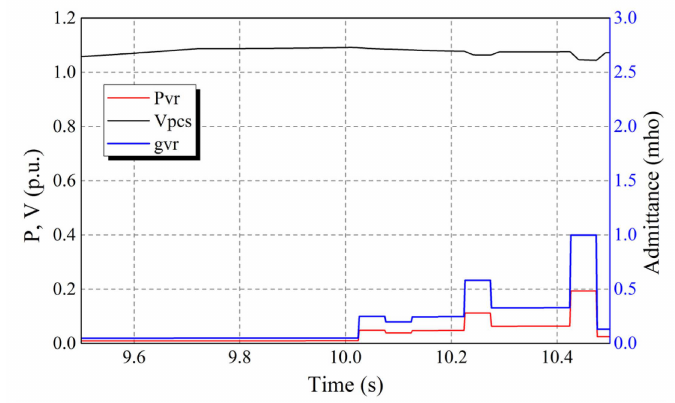
Figure 16. Admittance and pcs voltage variation in Case 2 (9.5–10.5 s).